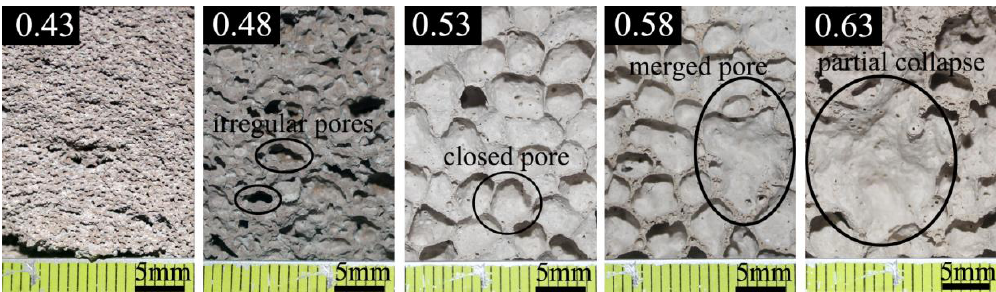
Figure 2. Surface morphology of specimens with different water–cement ratios. Materials 2019 , 12 , x FOR PEER REVIEW